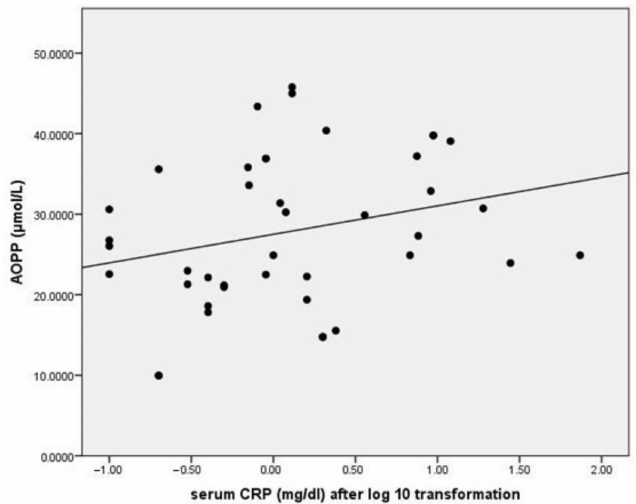
Figure 7. Correlation between AOPP and serum C-reactive protein (after log-10 transformation). Legend: AOPP = advanced oxidation protein